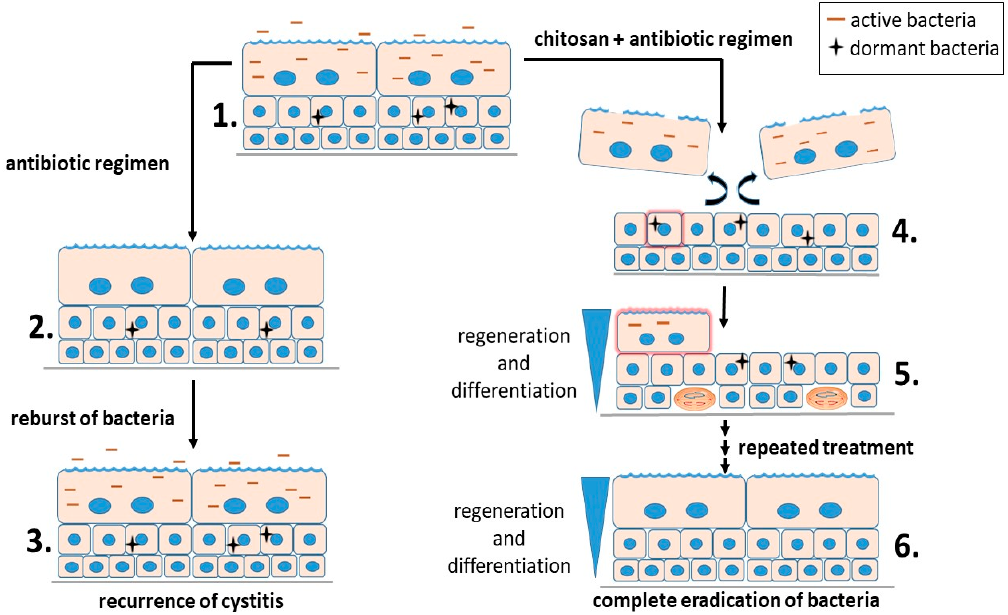
Figure 5. Two treatment regimens of infected urinary bladder epithelium. ( 1 ) Both active and dormant bacteria dwell in infected urothelial cells. ( 2 ) Antibiotic regimen efficiently clears active bacteria from both urine and host cells. However, immature urothelial cells retain dormant bacteria. ( 3 ) From the nests of dormant bacteria, new outbursts of bacteria appear periodically. ( 4 ) Treatment with a combination of chitosan and antibiotics induces a detachment of umbrella cells and activates differentiation of immature cells (red glowing cell). ( 5 ) Dormant bacteria reactivate in such differentiating cells (red glowing cell) and become again sensitive to antibiotics. Proliferating basal cells enable fast replacement of lost umbrella cells. ( 6 ) By repeated treatment with chitosan and antibiotics, bacteria become completely eliminated from urine and urothelial cells.